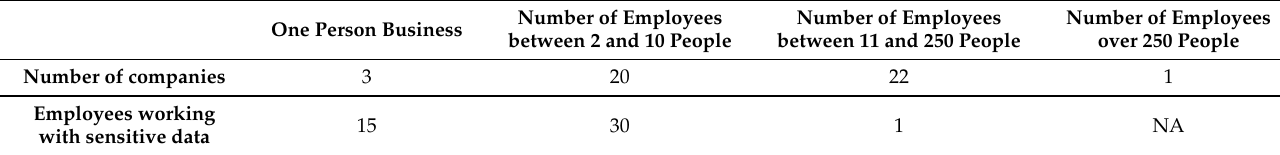
Table 2. Number of companies/employees with access to sensitive